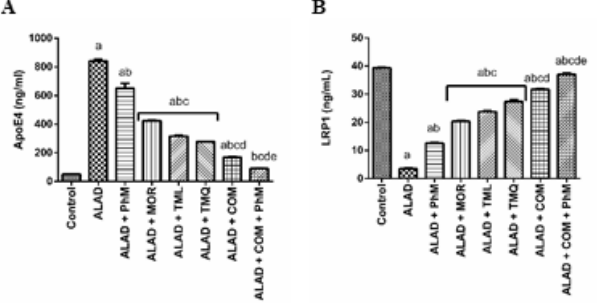
Figure 7. The effect of phytochemicals combination, MOR, TML, and TMQ, with PhM on ApoE4 and LRP1 levels in AD. ( A ) ApoE4 levels and ( B ) LRP1 levels. The data are presented as means ± SD